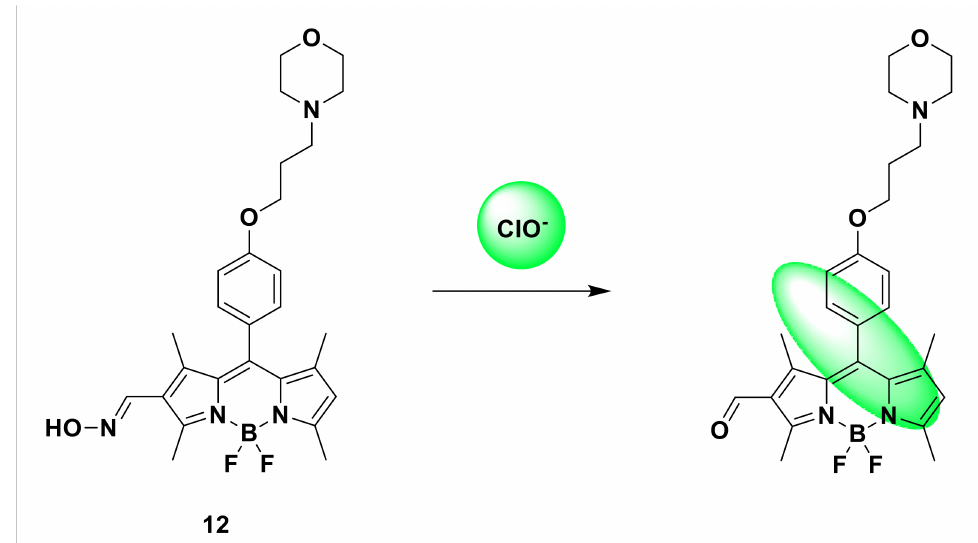
Figure 14. The reaction of probe 12 and ClO − .